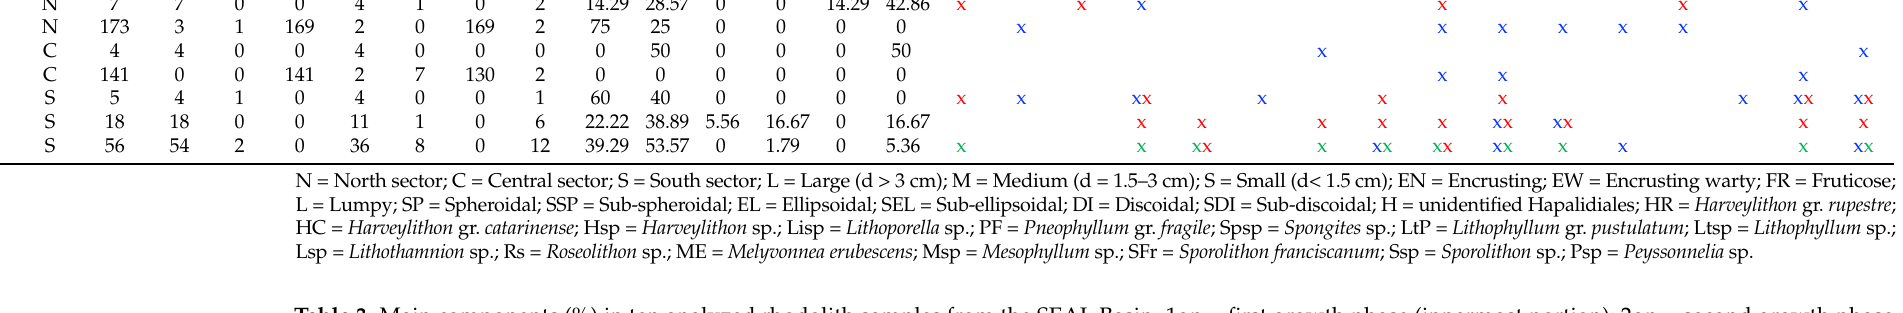
Table 3. Main components (%) in ten analyzed rhodolith samples from the SEAL Basin. 1gp = first growth phase (innermost portion); 2gp = second growth phase (outermost